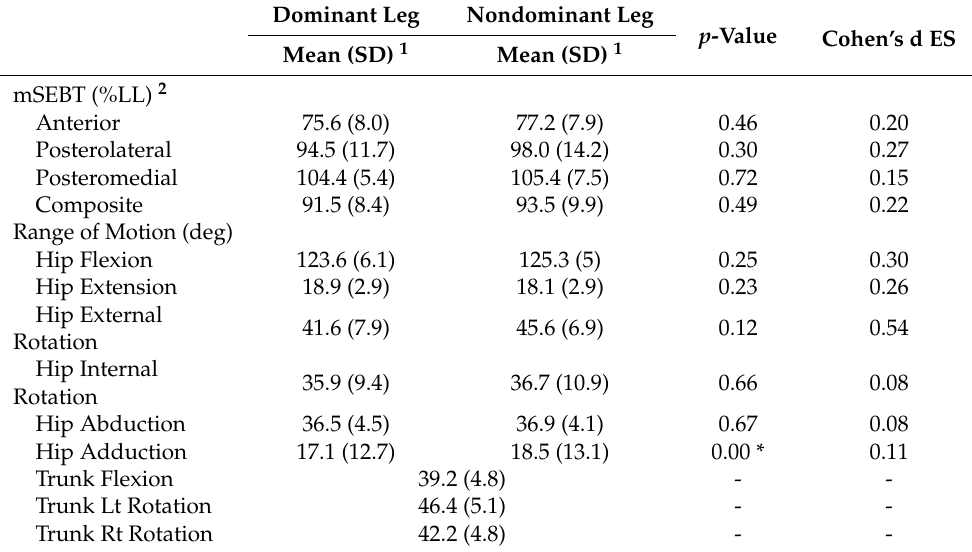
Table 2. Comparison of the mSEBT and ROM of hip and trunk between the dominant and nondomi- nant